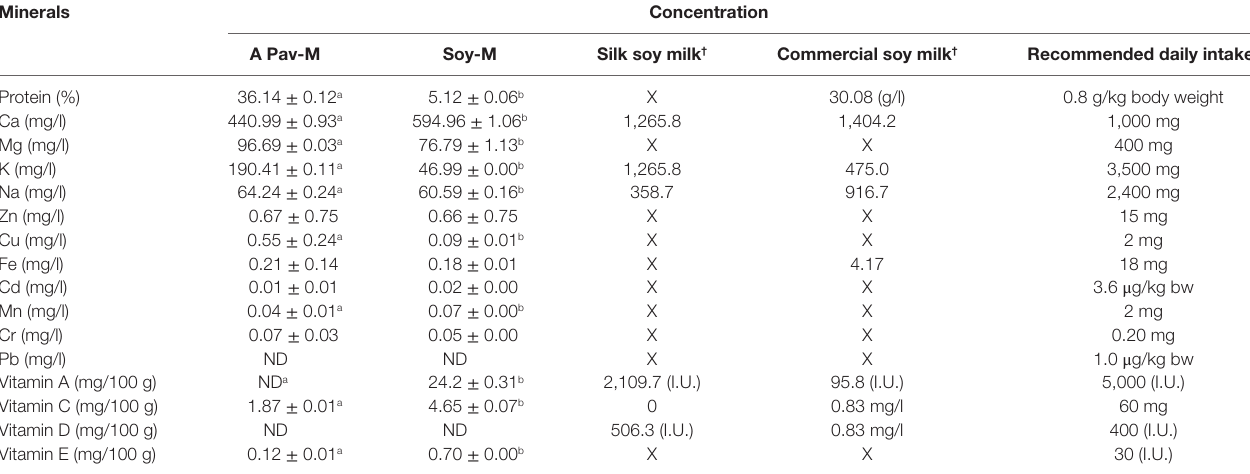
TaBle 2 | Some basic nutritional profile of milk extract from Adenanthera pavonina and soy bean. Minerals